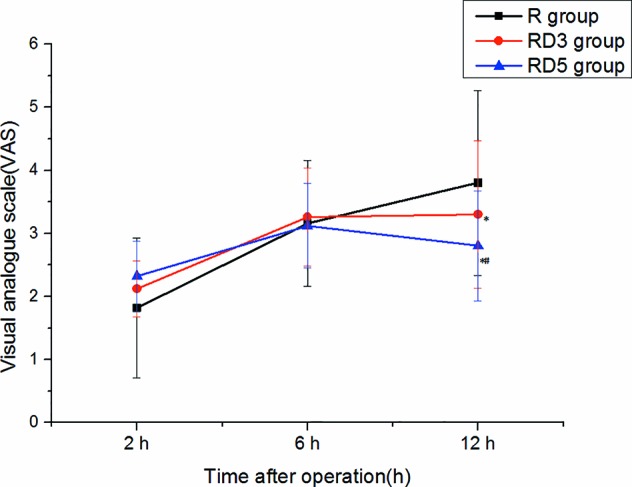
Visual Analogue Score (VAS) pain scores of the three groups. *p < 0.05 was considered statistically significant compared with the R group. #p < 0.05 was considered statistically significant compared with the RD3 group.